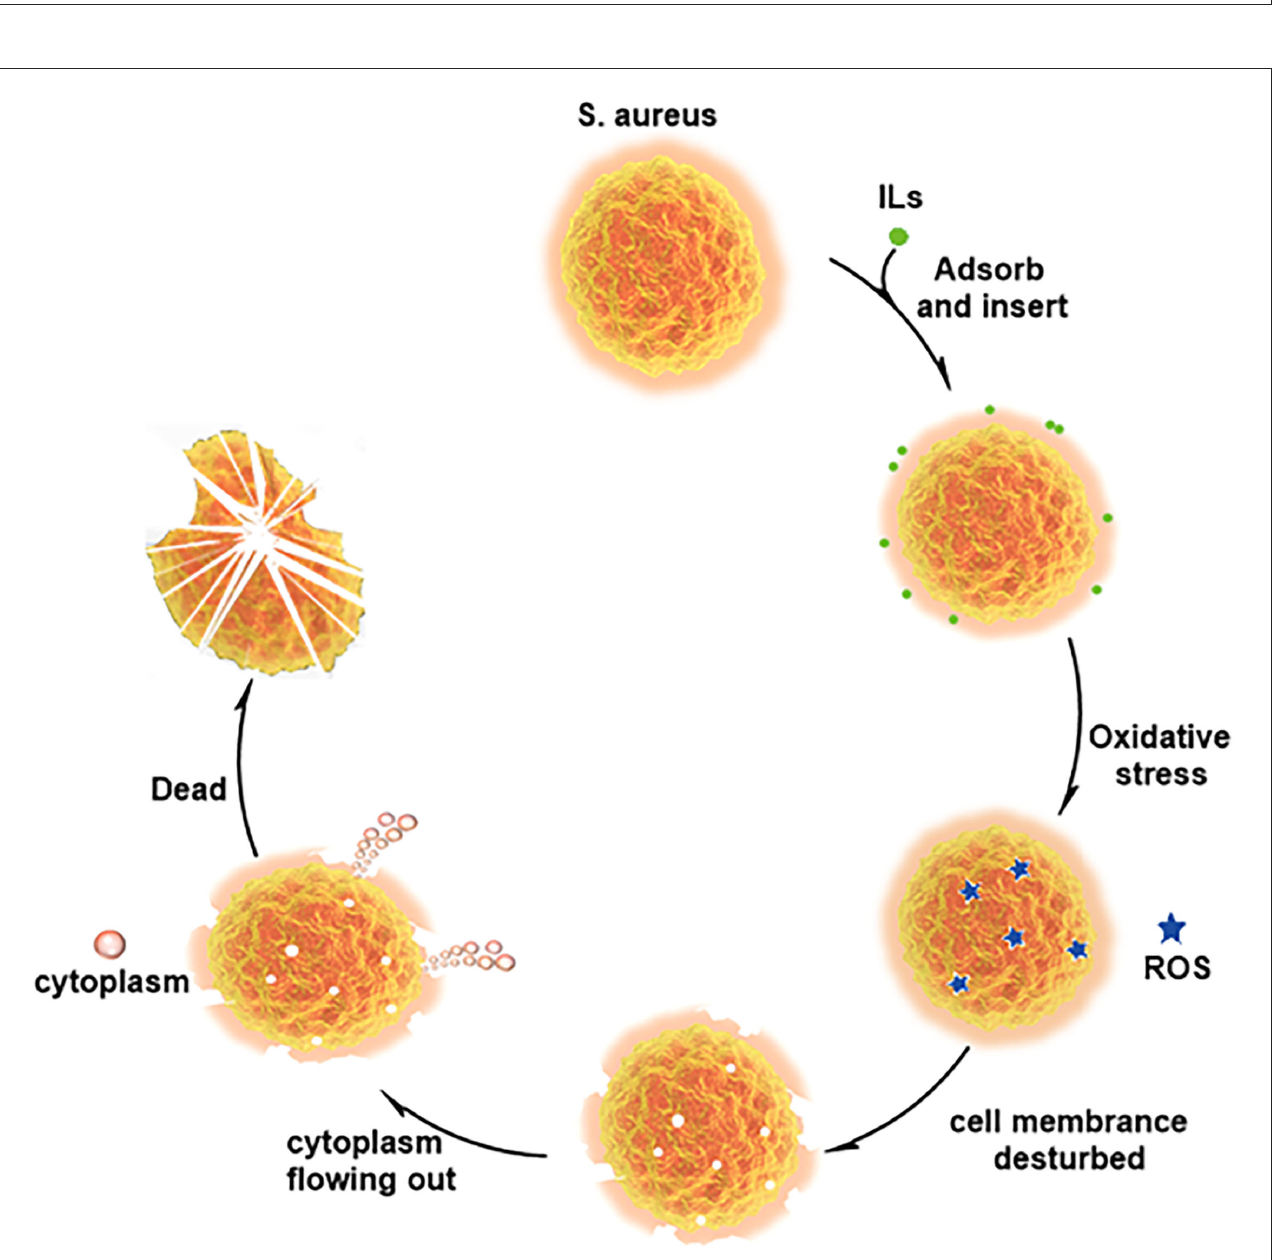
FIGURE7 Plausible antibacterial mechanism for interaction between C 12 MIMCl and Staphylococcus aureus